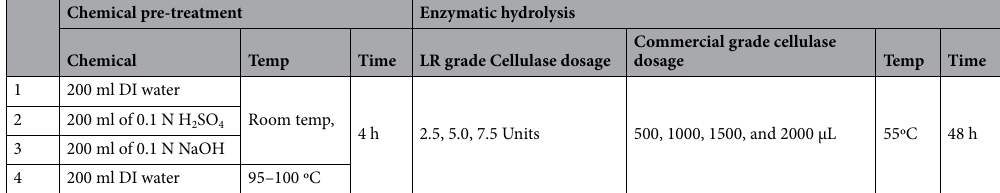
Table 2. Experimental investigation for four different pre-treatment methods of integrated enzymatic hydrolysis.